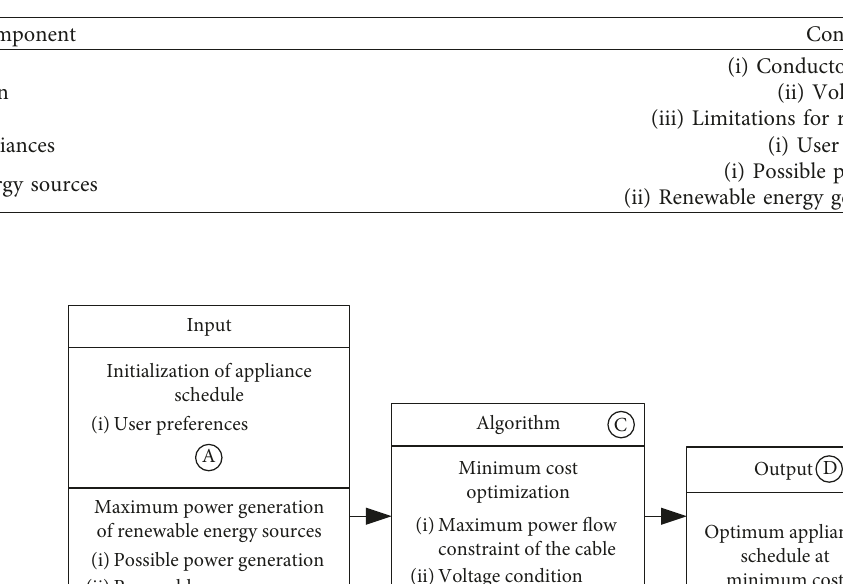
Table 2: Constraints considered.